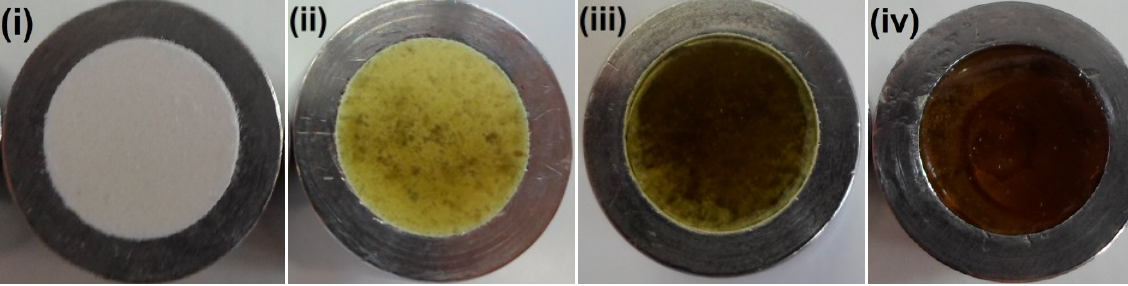
Figure 2. Macroscopic images after compaction: ( i ) crystalline IND (125 MPa); ( ii ) amorphous IND (187 MPa); ( iii ) amorphous IND (312 MPa) and ( iv ) quenched-in